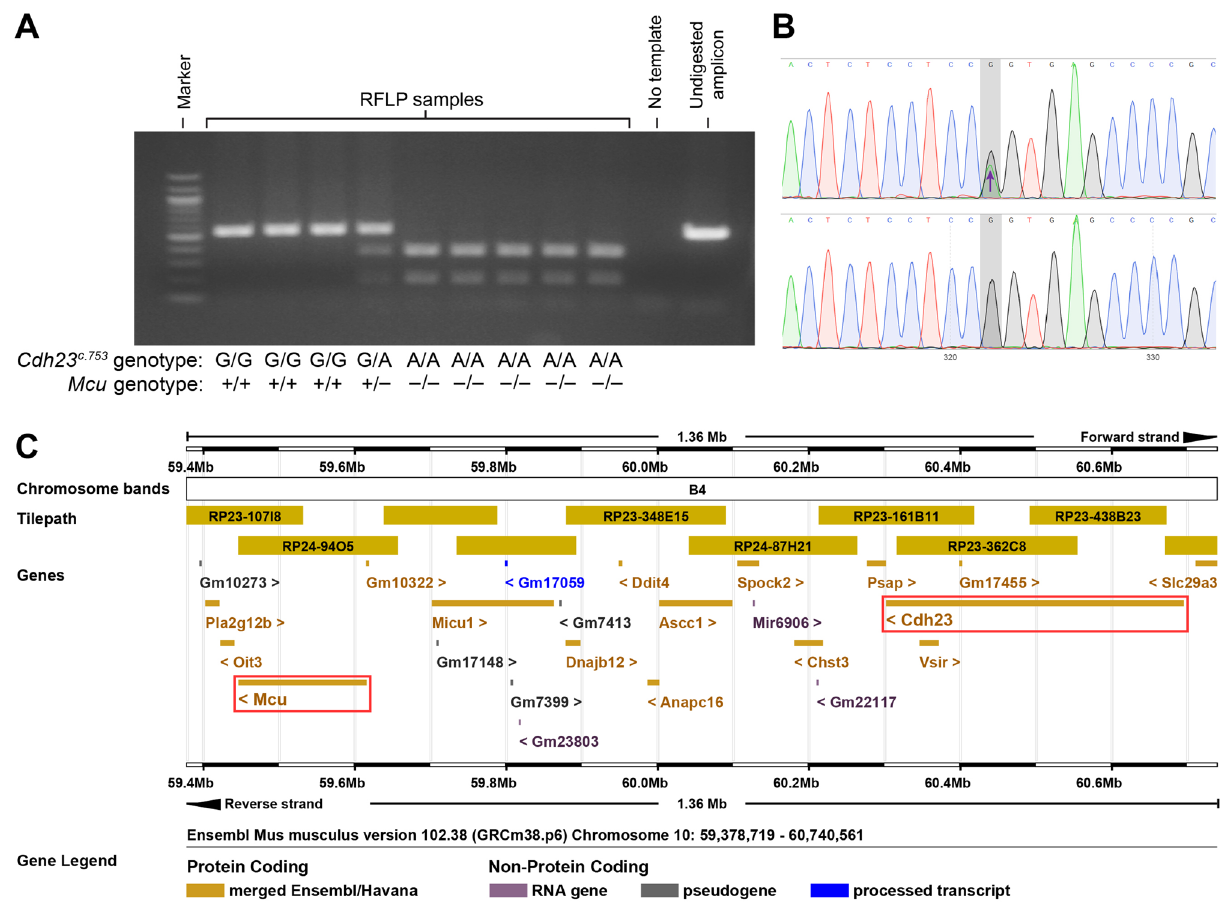
Figure 3. PCR and restriction fragment length polymorphism (RFLP) based genotyping of Cdh23 c.753A/G in FVB/NJ Mcu −/− mice. ( A ) A representative electropherogram showing the PCR amplicons resolved in a 1.5% agarose gel following digestion with BsrI . The Cdh23 c.753G allele renders the binding site for BsrI inaccessible to digest the PCR amplicon of 534 bp, while the Cdh23c. 753A allele creates a BsrI binding site resulting in fragments of 350 bp and 184 bp. ( B ) DNA sequence chromatogram validates the PCR–RFLP method to genotype Cdh23 c.753A/G polymorphism. The top panel shows a heterozygous Cdh23 c.753A/G allele previously identified by restriction with BsrI . The bottom panel shows a homozygous for Cdh23 c.753G sample unaffected by BsrI . ( C ) Ensembl-based analysis shows genes in a 1.36 Mb region of mouse Chr.10qB4. The genes Mcu and Cdh23 (red boxes) are closely located with an intergenic distance of ~ 686 Loss of cochlear hair cell stereocilia in three month old Mcu −/− mice. The elevated ABR thresholds observed at one month of age in Mcu −/− mice were not paralleled by any apparent morphological and structural changes in HCs. Hence, we inspected the structural integrity of HCs at 3 months of age (Fig. 7). A fraction of the outer hair cells (OHCs) were missing and the stereociliary bundles of the OHCs that were present showed signs of degeneration in the Mcu −/− mice. Specifically, the third row of hair bundles was affected by the degenerating stereocilia at the edges (Fig. 7A,B lower panel). Occasionally, a few inner hair cells (IHCs) were lost in the Mcu −/− mice. IHC hair bundles of Mcu −/− mice lacked the third, the shortest, row of stereocilia, in striking contrast to hair bundles of Mcu + / + and Mcu + /− mice (Fig. 7C,D lower panel). In the Mcu + /− mice, the number of OHCs that were missing was comparably less than in the Mcu −/− mice but higher than in the Mcu + / + littermates (Fig. 7A, middle panel). The stereociliary bundles of both the OHCs and the IHCs appeared normal in the Mcu + /− mice, and no IHCs were lost. Moreover, we enumerated the number of OHCs present in the apical, middle, and basal regions of Mcu −/− cochlea compared to Mcu + /− and Mcu + / + littermates. This analysis revealed that the mid-coch- lear region was the most susceptible in the Mcu −/− mice with only 82.3% of the OHCs present in contrast to the > 96% of OHCs present intact in Mcu + /− and Mcu + / + littermates (Fig. 7E). Another observation was the loss of ~ 10% of OHCs in the apical region of both Mcu −/− and Mcu + /− mice in comparison to the corresponding value of 4% in Mcu + / + littermates. However, this difference was not statistically significant. In addition, around 10% of OHCs in the basal region of the cochlea of all three genotypes were observed to be lost. In conclusion, our data suggest that MCU and rapid uptake of Ca 2+ is important for hearing preservation and long-term maintenance of auditory hair cells in congenic FVB/NJ mice.